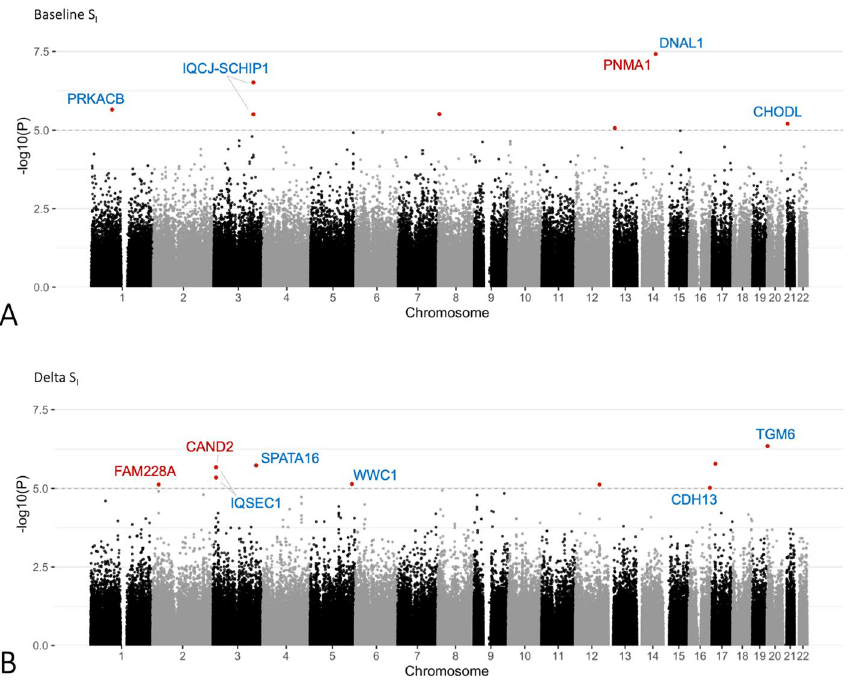
Figure 2. Manhattan plots showing genetic loci associated with baseline and ∆S i and their mapped genes. Genetic loci reaching at least suggestive association are represent by points highlighted in red. Genes mapped to these loci are annotated, where genes mapped by position are highlighted in blue, and genes mapped by eQTL are highlighted in red. Highlighted loci showing no gene annotation did not map to any genes according to the criteria we used. For additional details, see Table